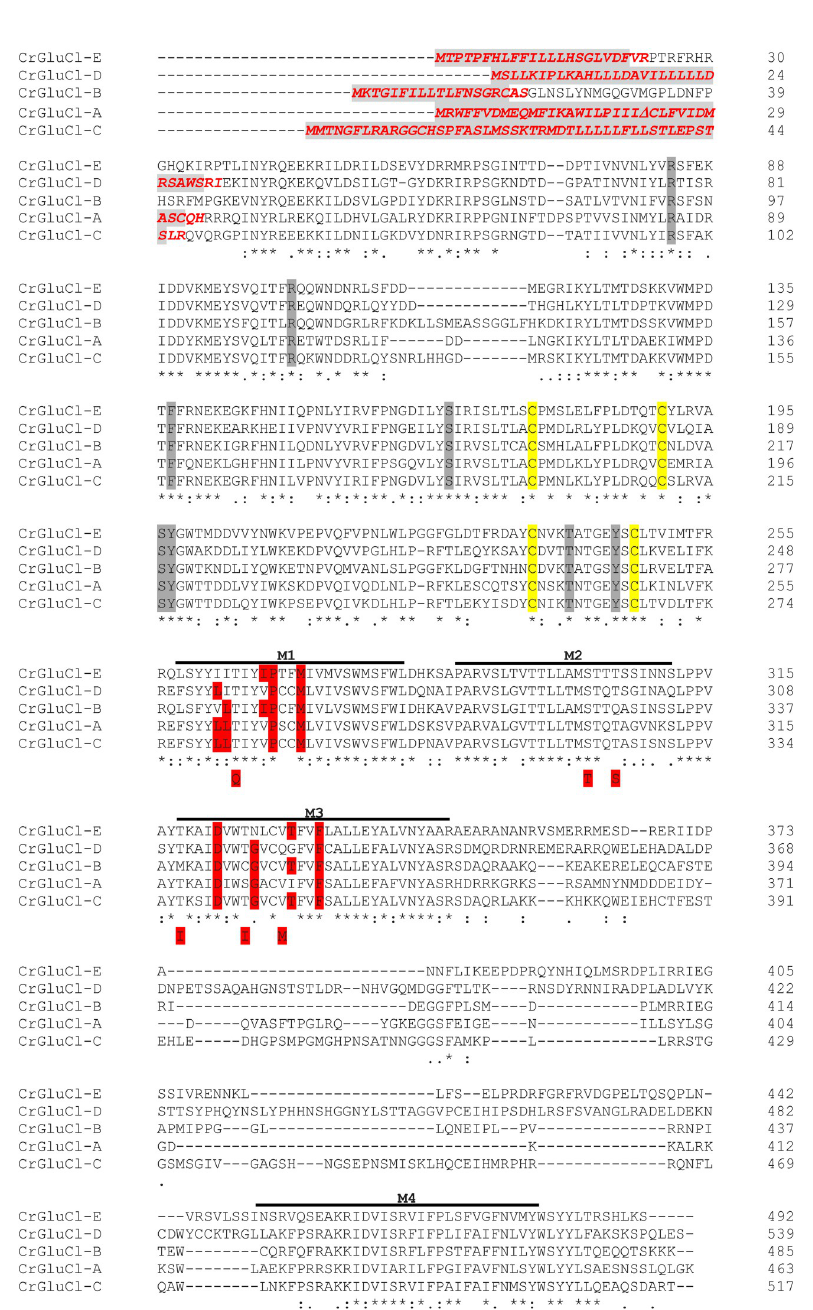
Fig 1. Predicted amino acid sequences for CrGluCl-A, -B, -C, -D and -E. Putative signal peptides (SignalP 4.1 Server) are shown in red italics with the cut portions shaded in gray. Cysteine residues necessary to the formation of C- loops are highlighted in yellow; in grey and in red are residues involved in glutamate and ivermectin binding respectively. The position of the transmembrane domains and binding sites, as well as the residues involved in glutamate and ivermectin binding, are based on the crystal structure of the C . elegans GluCl α [17]. Highlighted in red and below the sequences are amino acids that participate in ivermectin binding in C . elegans GluCl α but are not conserved in the CrGluCl subunits. The sequences for CrGluCl-A, B, C, D, and E are deposited in the GenBank under identifiers KX599189, OP737386, OP737387, OP737388 and OP737389 respectively. Alignments generated using Clustal Omega (https://www.ebi.ac.uk/Tools/msa/clustalo/).